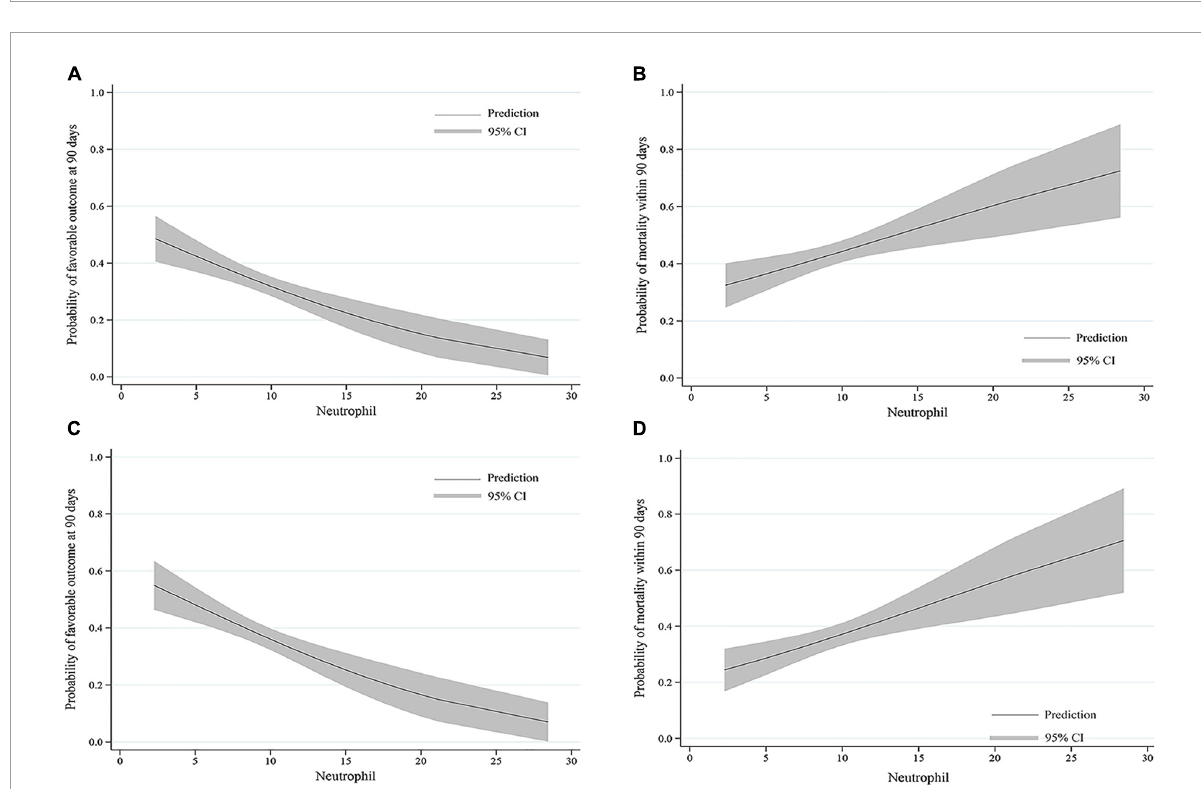
FIGURE3 Predicted probability of clinical outcomes by neutrophil count. The curves show a decrease in the estimated probability of favorable outcomes and an increase in the predicted probability of mortality with higher neutrophil counts in (A,B) all patients and (C,D) patients who were successfully recanalized. The solid line shows the predicted probability of outcomes. The shaded area indicates the 95% confidence interval